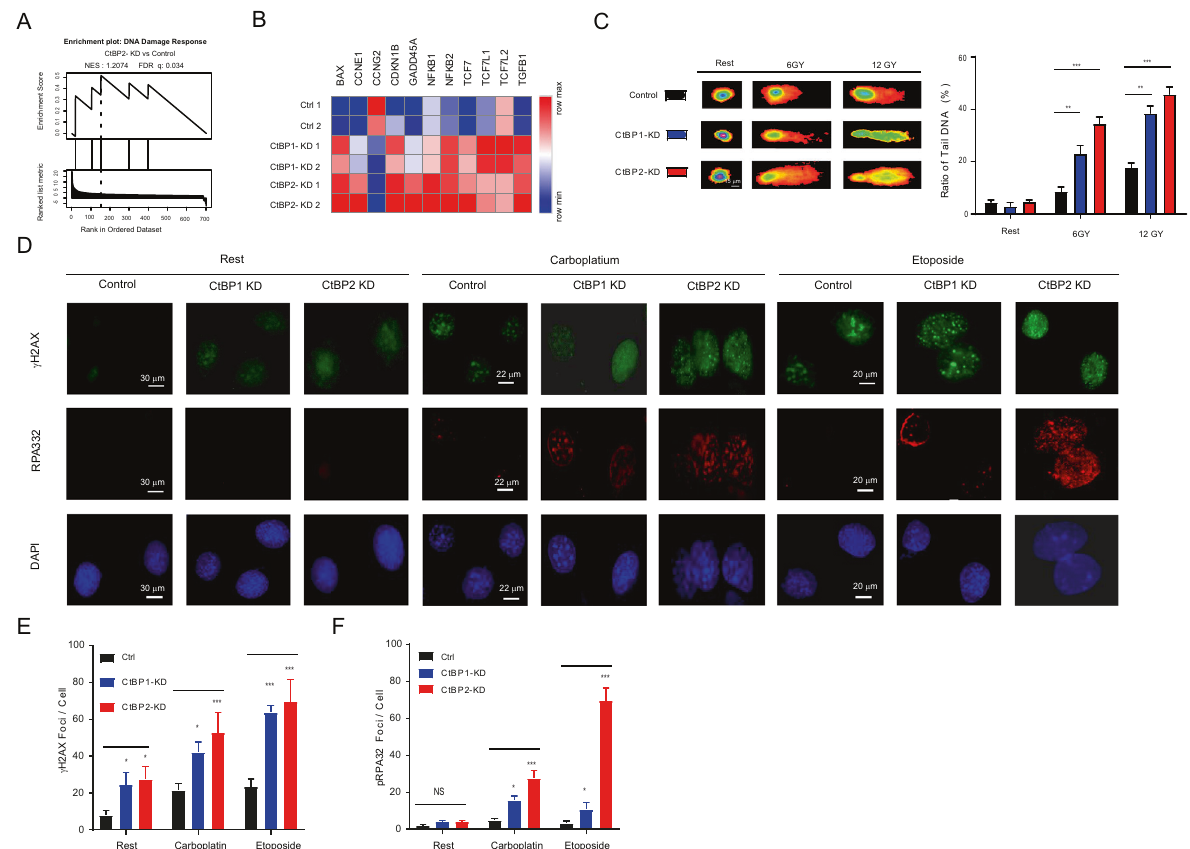
Fig. 3 CtBP1/2 knockdown increased the sensitivity to DNA damage response in ovarian cancer cells. The upregulated genes in CtBP2 KD vs. control were enriched in DNA damage response as assessed by GSEA ( A ). Heat maps signi fi cantly compared expression of genes that involved in DNA damage response regulation in CtBP1/2 KD and control groups ( B ). Comet assay analyzed the DNA damage response the after g-irradiation treatment (6 and 12 Gy) on ovarian cancer cells. The ratio of tail DNA was as quantitative analysis ( C ). Immuno fl uorescence of γ H2AX and RPA32 phosphorylation detected in control and CtBP1/2 KD cells after cell treated with carboplatin and etoposide ( D ). Nuclear DNA was counterstained with DAPI. Quantitative analysis foci formation per cell in each group was performed by Image J and presented as γ H2AX foci/cell ( E ) and RPA32 foci/cell ( F ). Rest represented without stimulation. For each sample, 100 cells were blinded and scored independently by two markers. * P < 0.05; ** P < 0.01; *** P <